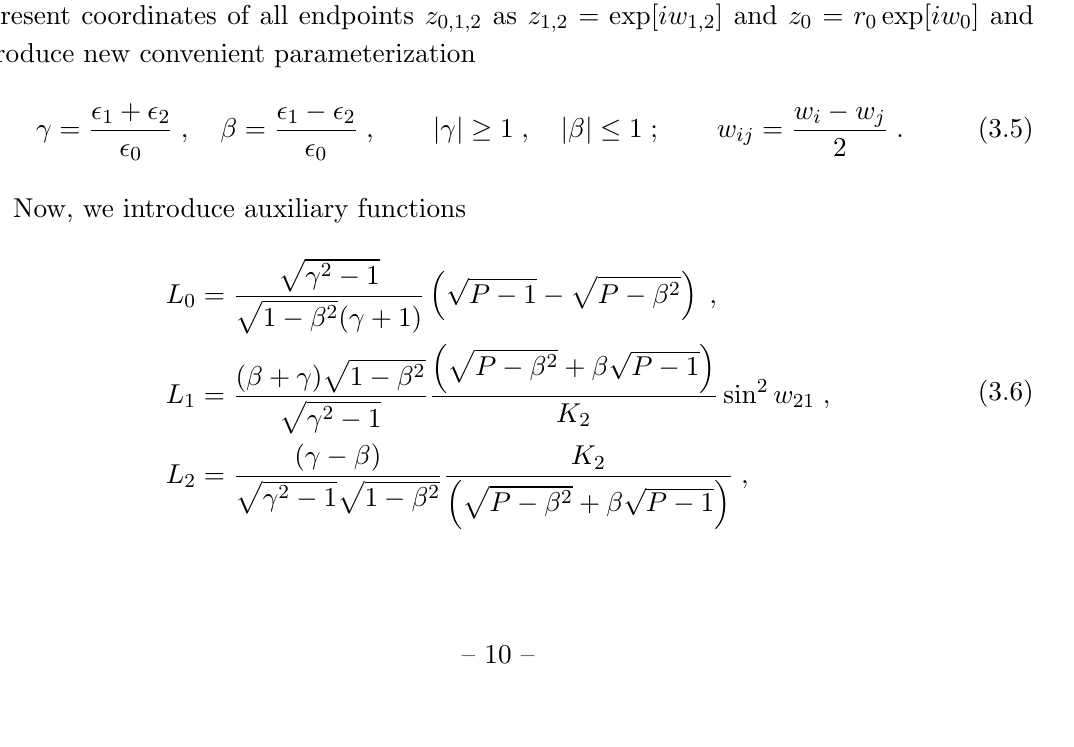
Figure 6 . N=2 and other